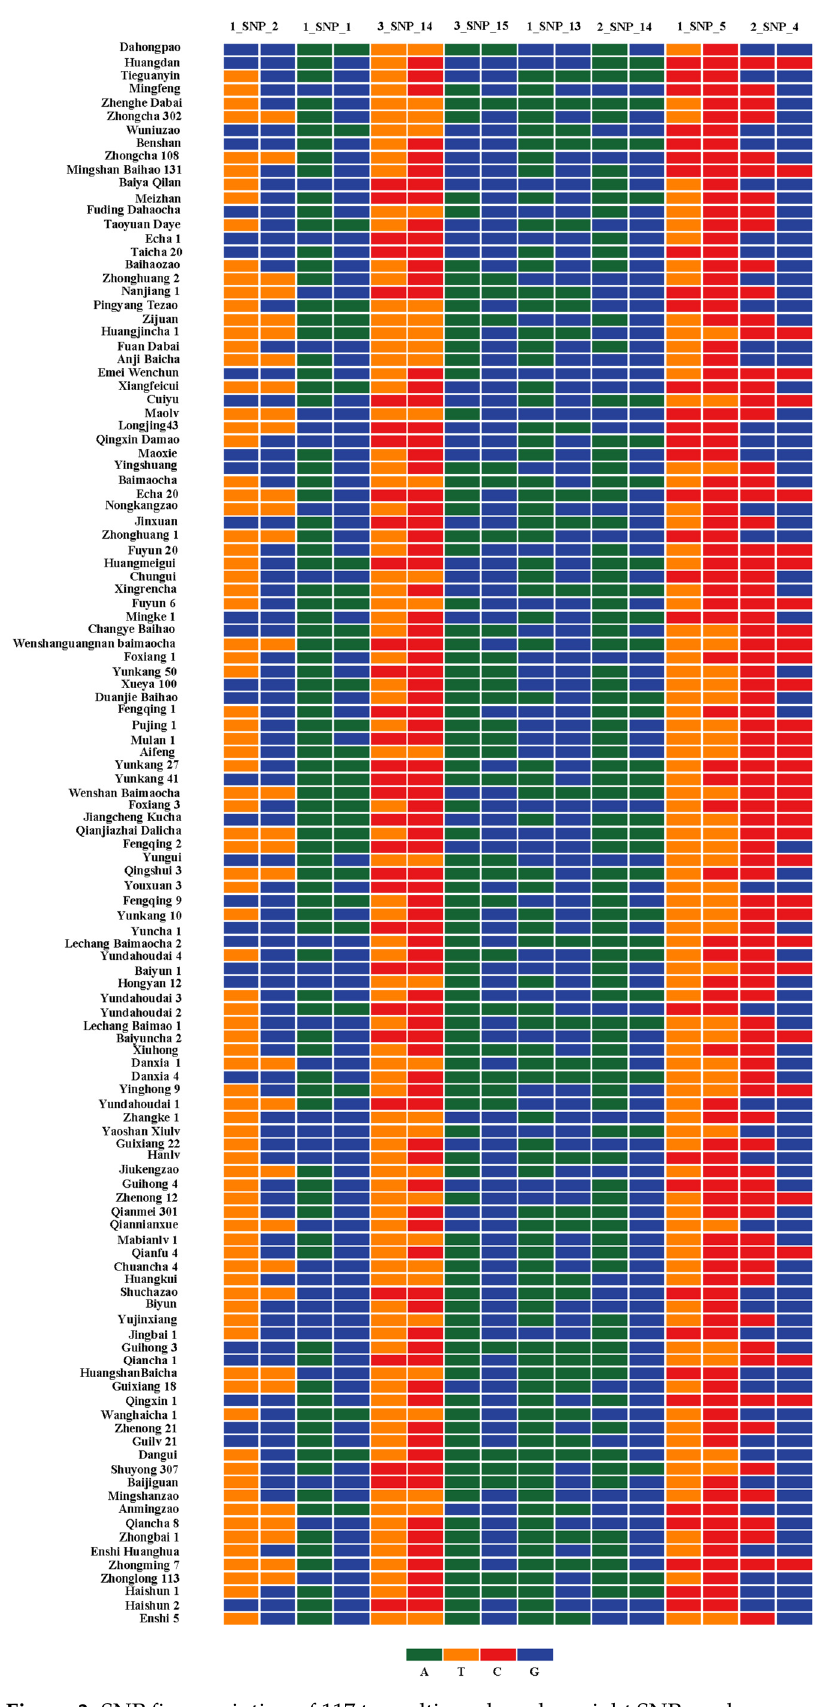
Figure 3. SNP fingerprinting of 117 tea cultivars based on eight SNP markers.